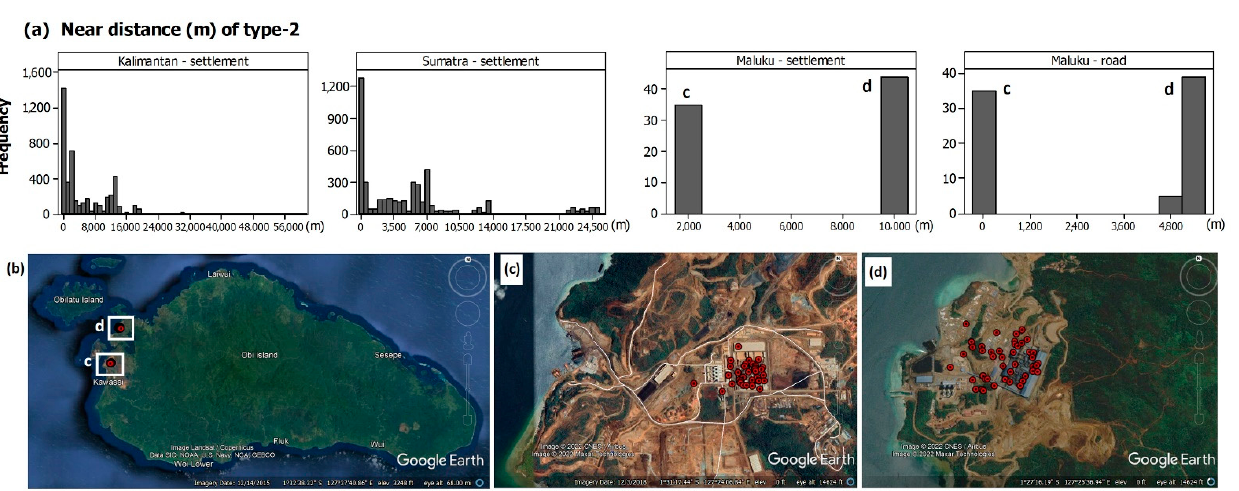
Figure 6. ( a ) The histogram distribution for near-distance analysis between type-2 data to the settlement areas in Kalimantan, Sumatra, and Maluku, and near distance of type-2 to the roads in Maluku; ( b ) the spatial location for type-2 data in Maluku overlaid on high spatial images from Google Earth; ( c ) enlarged image for the first hotspot cluster (red dots) situated in industrial mining area with GIS road features (white lines); ( d ) enlarged image for the second hotspot cluster (red dots) in industrial mining area; no road features. Both hotspot clusters located in coastal areas.